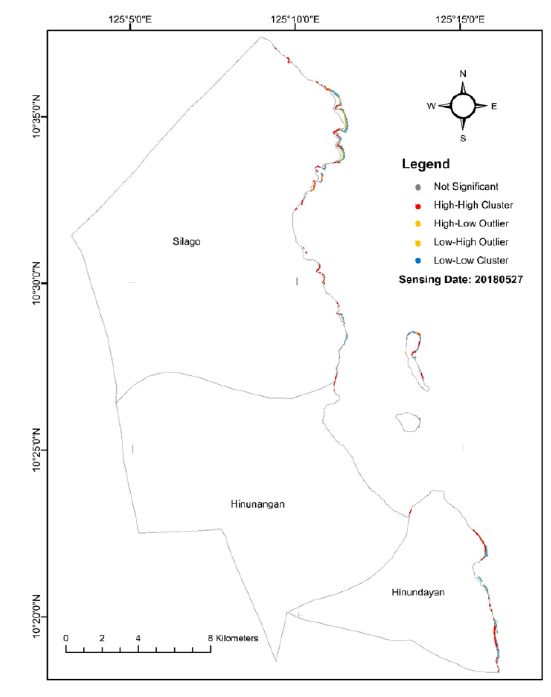
Figure 10. Cluster & Outlier Analysis of Sargassum in May Sentinel image